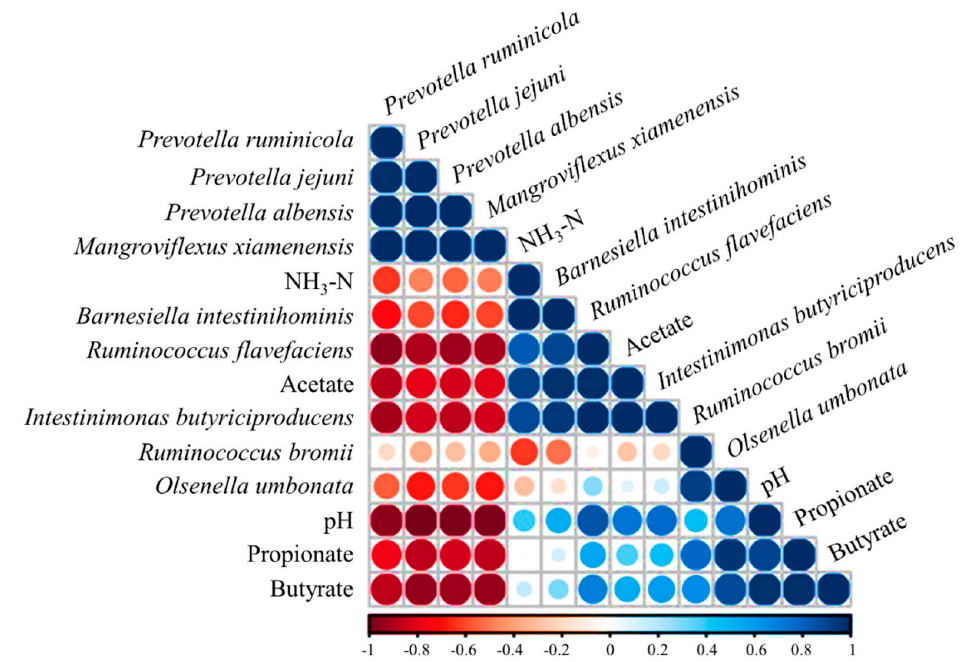
Figure 7. Correlation plot showing the Pearson’s correlation coefficient between the rumen fermentation parameters and the predominating rumen bacterial species. Statistically significant values are shown ( p < 0.05). Strong positive and negative correlations are displayed in blue and red, respectively, and less strong correlations are shown in lighter shades. Color intensity and the size of the circle are proportional to the correlation coefficients. The figure was generated using statistical tools for high-throughput data analysis (STHDA) [44].